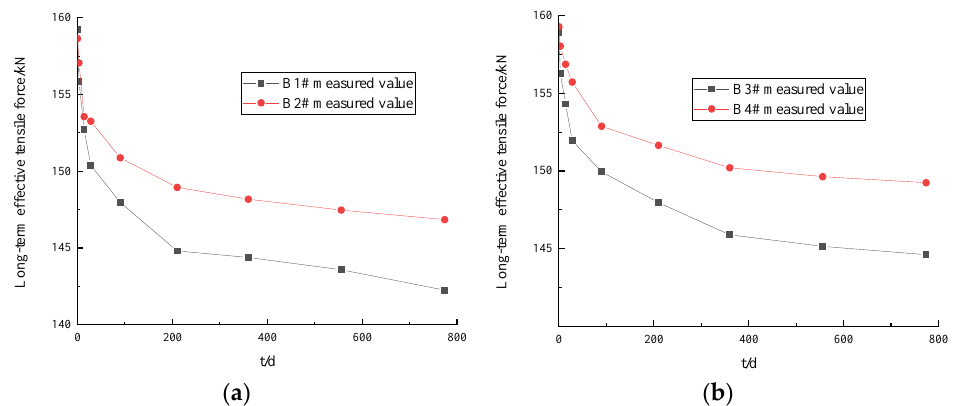
Figure 5. Results of long-term effective tensile test of test T-beam: ( a ) loading age = 7 d; ( b ) loading age = 28 d.